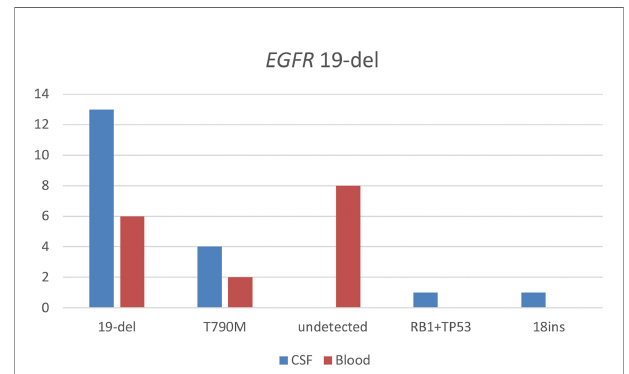
FIGURE 1 | Detection of somatic mutations in paired cerebrospinal fl uid (CSF) and blood samples of patients with leptomeningeal metastasis (LM) harboring EGFR exon 19 deletion (19del) detected from tissue samples before LM diagnosis. 18ins, EGFR exon 18 insertion; RB1+TP53, a mutation